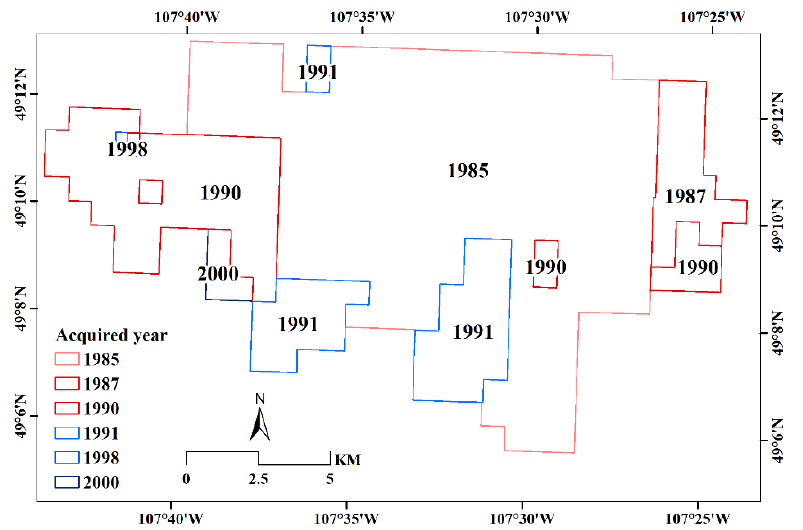
Figure 1. Location and acquisition years of native prairie in the west block of Grasslands National Park (GNP), Saskatchewan, Canada. The information of acquisition years was provided by GNP. After the lands were acquired for the national park, all livestock grazing ceased, with only very light use by native grazers (mule deer ( Odocoileus hemionus ), white-tailed deer ( O. virginianus ), pronghorn ( Antilocapra americana )) occurring [49]. This initiated the process of secondary succession by modifying the pressures and disturbances [50] and allowed the native prairie vegetation community to rest and conserve its biodiversity. After a long period of grazing cessation (i.e., the management policy of removing larger grazers),